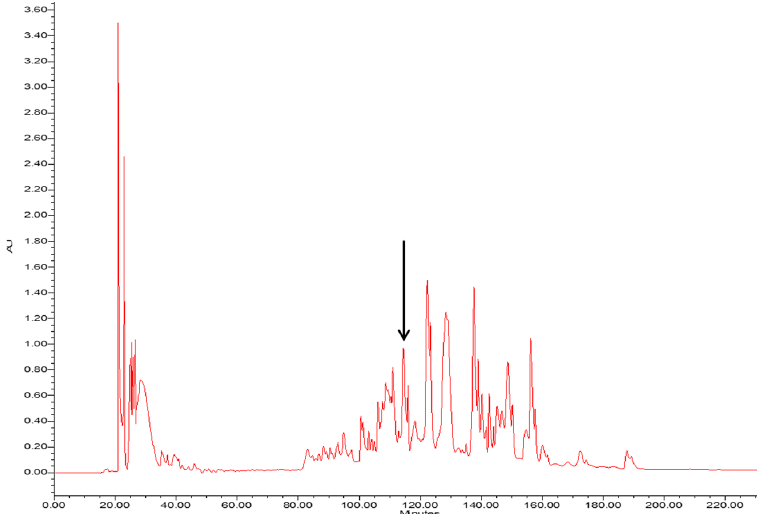
Figure 1. Nucleotide and translated open-reading frame amino acid sequences of cloned cDNA encoding the precursor of Phylloseptin-PT (PS-PT). The putative signal peptide is double-underlined, the mature peptide is single-underlined, and the stop codon is indicated by an asterisk.